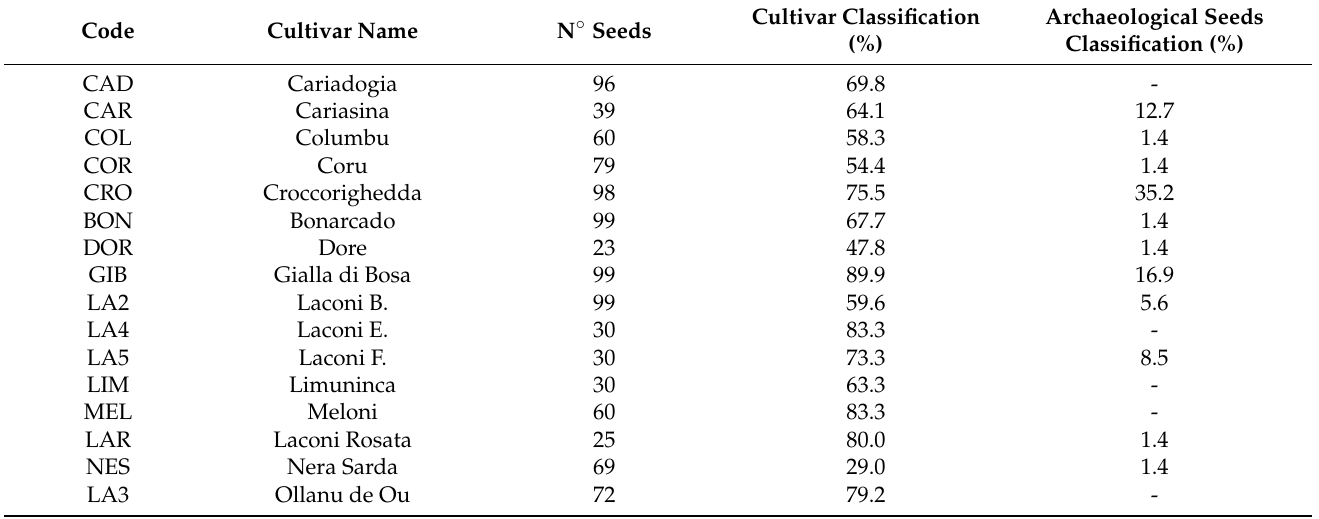
Table 1. LDA percentage results of comparison among modern Prunus domestica cultivars and Middle Ages fruit-stones considered as unknown.